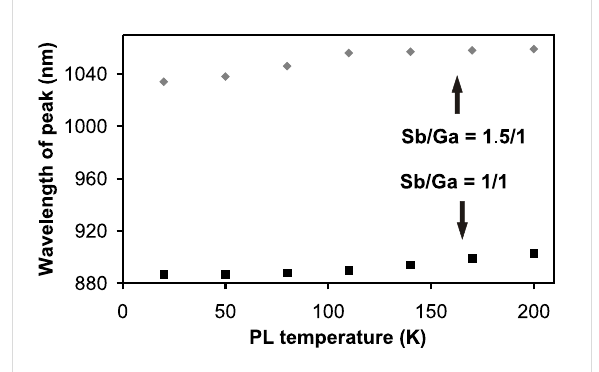
Figure 3: PL peak position for dots with larger diameter (at a V/III ratio 1.5/1) and smaller diameter (at a V/III ratio 1/1) plotted against sample temperature T PL